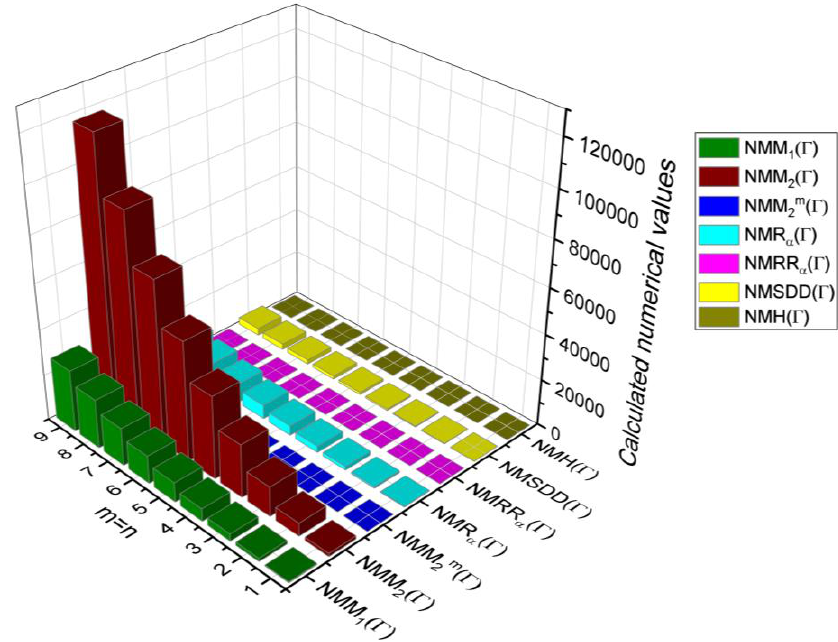
Figure 2. 3D plots for Theorem 2.